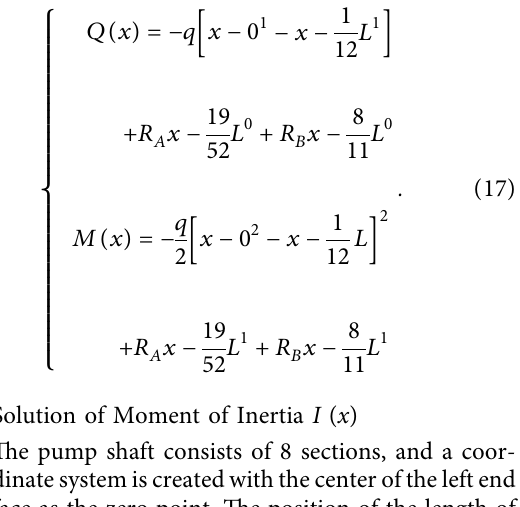
Table 9: Simulation results of axial force and radial force of each group.